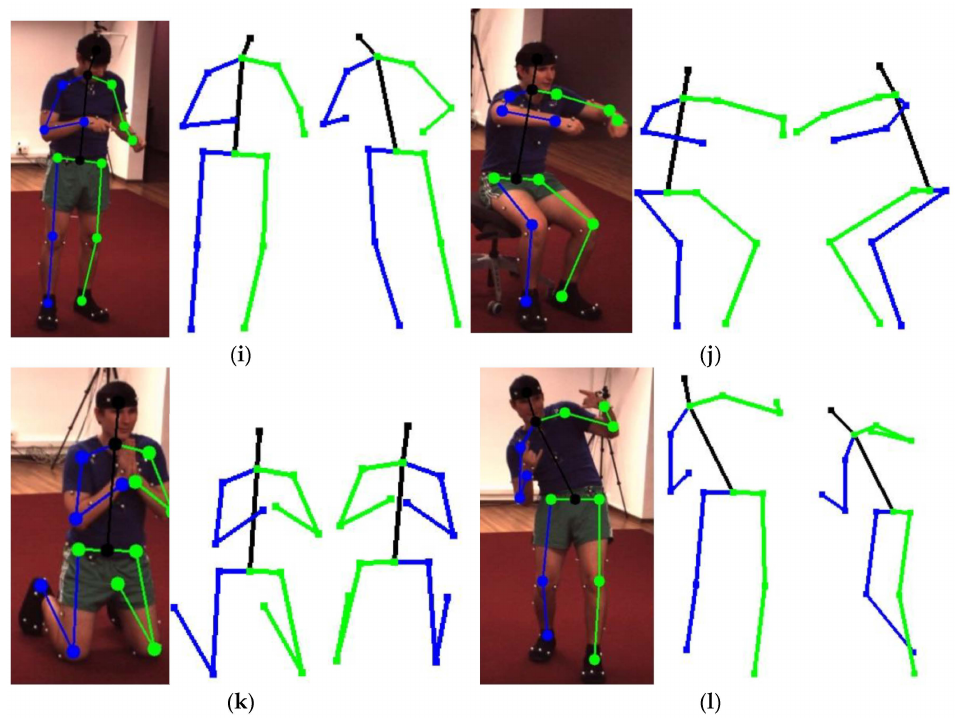
Figure 15. The visualization of G2O-pose. Subfigures ( a – l ) are the experimental results selected from the various actions of the two subjects. In every subfigure, a 2D image and 2D pose, 3D pose, and 3D pose from another random perspective are shown in sequence.